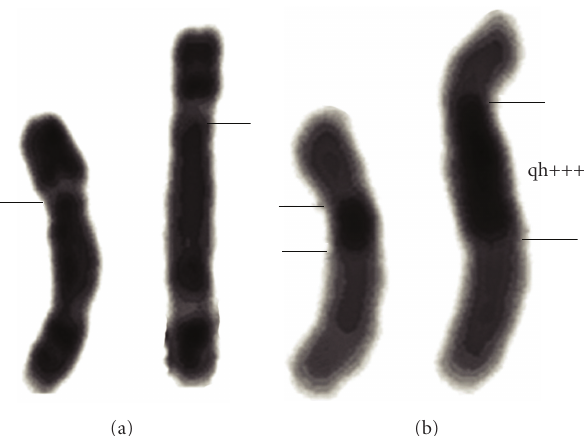
Figure 1: Karyotype analysis shows a 9qh+++ heterozygous state. (a) G-banding of homologous 9 chromosomes. Abnormal chromosome 9 (right) showing an increased length in the q arm compared to its homologous chromosome (left). Horizontal line indicates centromere position. (b) C-banding shows an increase in the heterochromatin region of chromosome 9. Horizontal lines set the limits of the qh